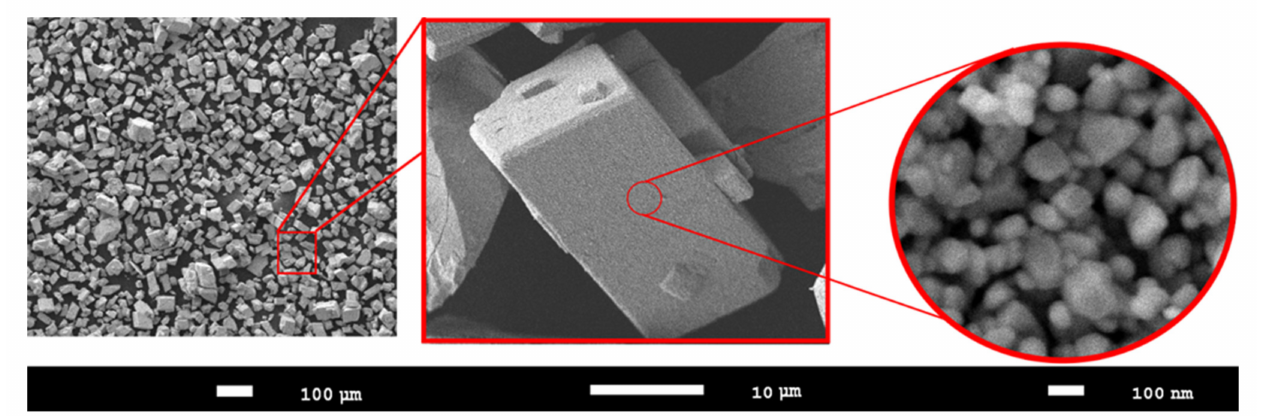
Figure 1. SEM images of the studied WO 3